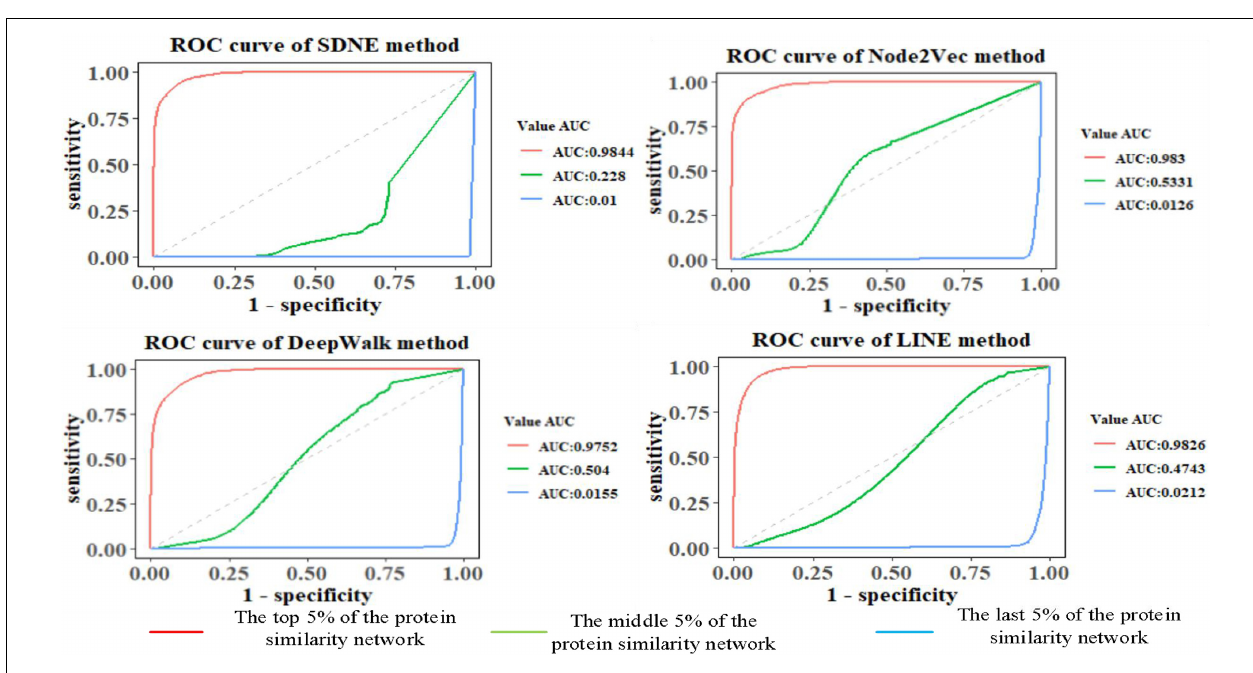
process for calculating the DTW distance is presented in Supplementary Figure 1